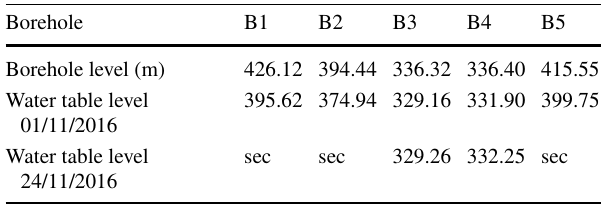
Table 2 Piezometric level variation of the water table Borehole